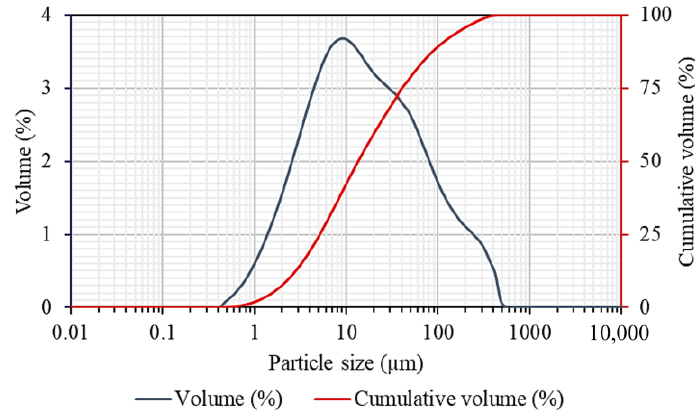
Figure 1. Particle size distribution of FA.